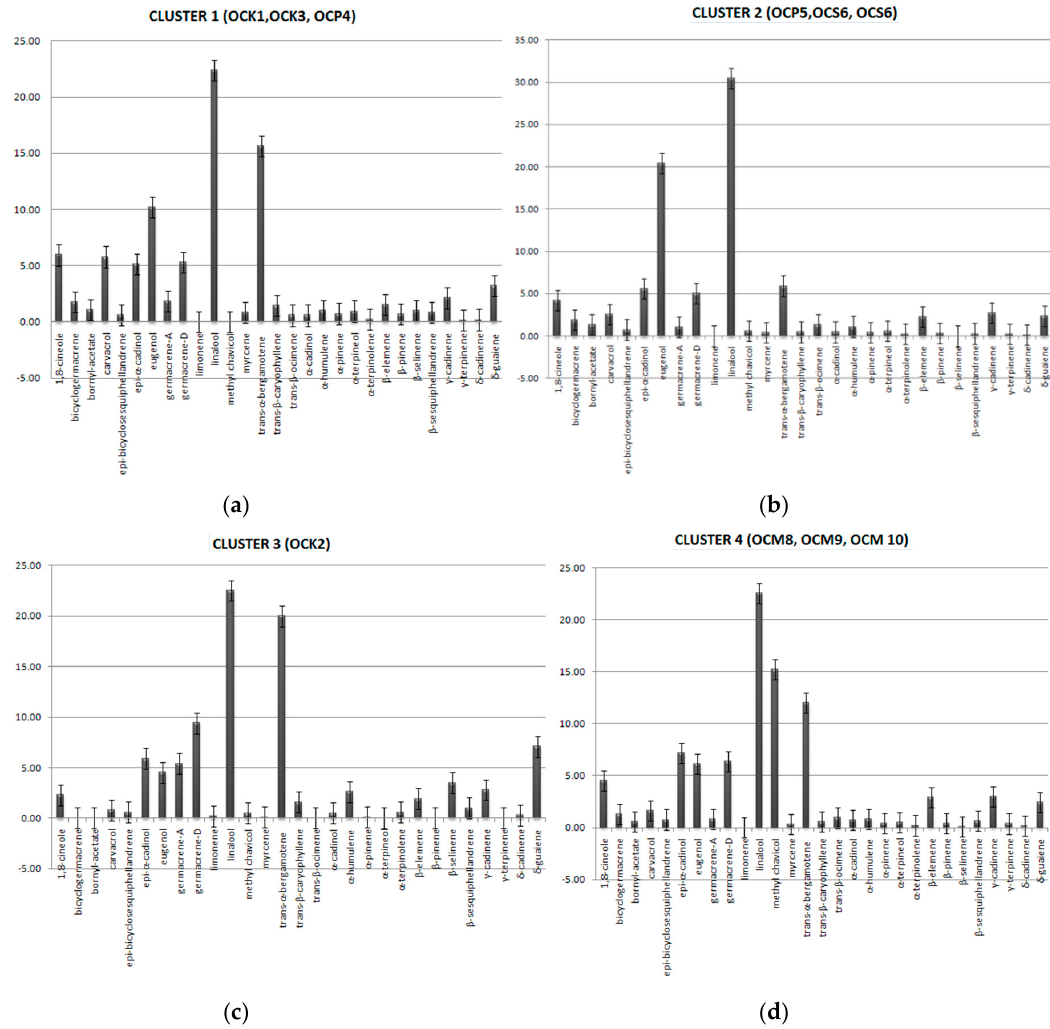
Figure 2. Clusters formatted according to the dominant compounds identified, in varieties violetto, latifolia, minimum and lettuce, cultivated in the greenhouse conditions. ( a ) Dominant compounds in var. violetto (1st and 3rd harvest) and var. latifolia (1st harvest); ( b ) Dominant compounds in var. latifolia (2nd harvest) and var. minimum (1st and 2nd harvest); ( c ) Dominant compounds in var. violetto (2nd harvest); ( d ) Dominant compounds in var. lettuce (1st, 2nd and 3rd harvest). Cultivation conditions in the field defined the dominant constituents for the formation of four clusters in the dendrogram (Figure 3). The similarities observed between harvests and varieties characterized the clusters as: Cluster 1 consisting of samples OCP11, OCP12, OCP13, OCS15, and OCS17 with linalool, eugenol, and trans - α -bergamontene as major components. Cluster 2 consists of OCP14 and OCS16 with linalool and eugenol as major components. Cluster 3 consists of OCM18, OCM19, and OCM20, with methyl chavicol and linalool as major components. Finally, cluster 4 is “simplicifolious” and consists of samples OCC21, OCC22, and OCC23, with methyl-chavicol as the dominant component. (Figure 4).